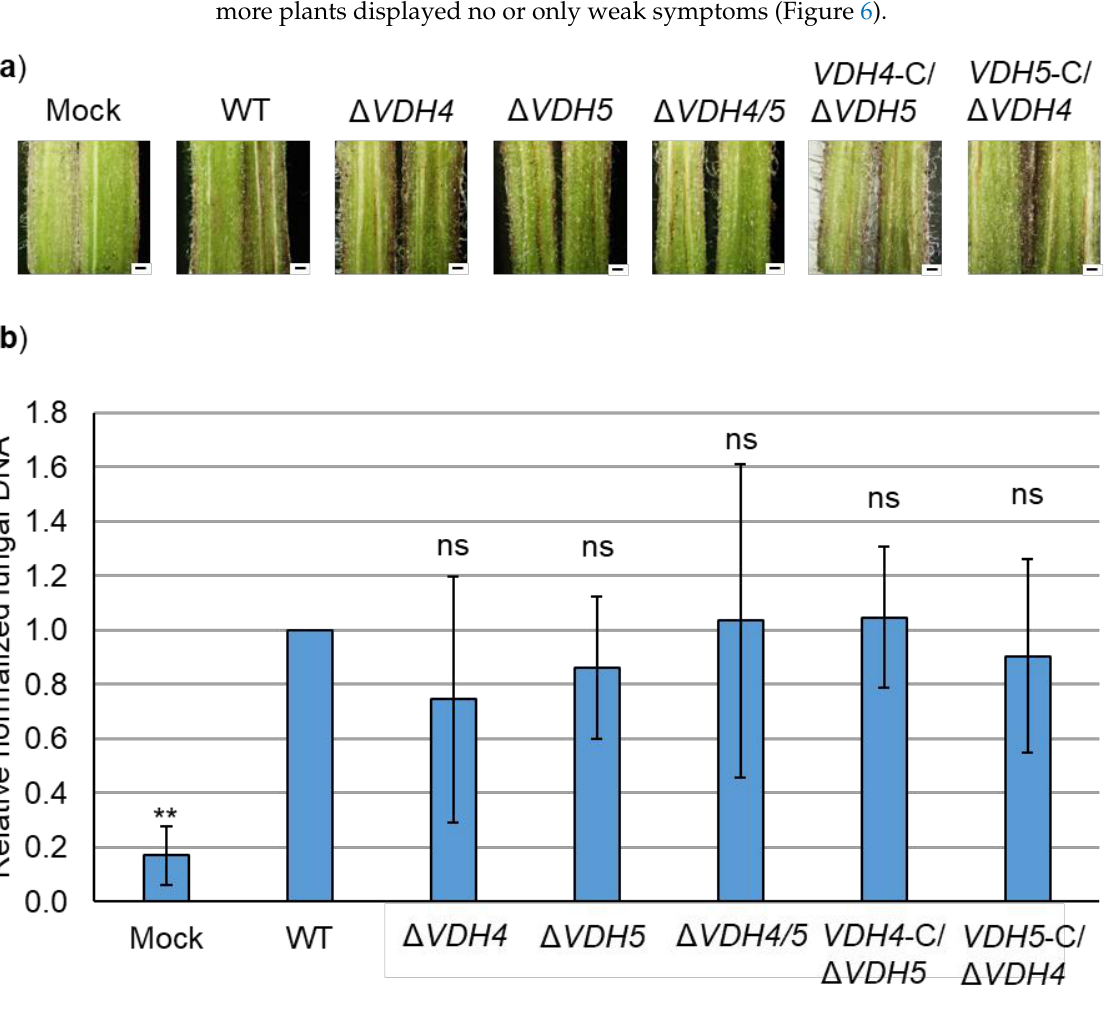
Figure 4. Hydrophobins Vdh4 and Vdh5 are dispensable for colonization of tomato hypocotyls by V. dahliae . Tomato seedlings were treated with water as a control (mock) or inoculated with V. dahliae spores by root-dipping. JR2 wild-type (WT), VDH4 ( ∆ VDH4 ), VDH5 ( ∆ VDH5 ), and VDH4/5 ( ∆ VDH4/5 ) deletion strains, or VDH4 ( VDH4 -C/ ∆ VDH5 ) and VDH5 ( VDH5 -C/ ∆ VDH4 ) single gene complementation strains in the double deletion strain background were used. The plants were then incubated in a climate chamber at 16 h: 8 h light: dark at 22–25 ◦ C for 21 days. ( a ) Cross-sections of representative hypocotyls (scale = 500 µ m) are shown. Hypocotyl discoloration was visible in plants treated with wild-type, all deletion or complementation strains, but not in mock-inoculated plants. ( b ) Fungal DNA in hypocotyls was analyzed by quantitative PCR relative to plant DNA. Means of four biological replicates from three independent experiments are shown. The error bars represent the standard errors of the mean. Significant differences from wild-type were calculated using Welch’s t -tests (ns, not significant; **, p < 0.01). Significantly lower levels of fungal DNA were detected only in mock-inoculated hypocotyls but not in plants inoculated with the indicated fungal strains.